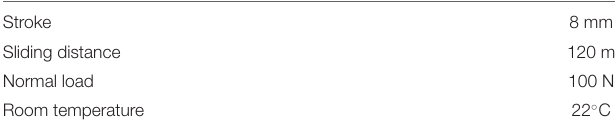
TABLE 3 | Imposed test conditions.